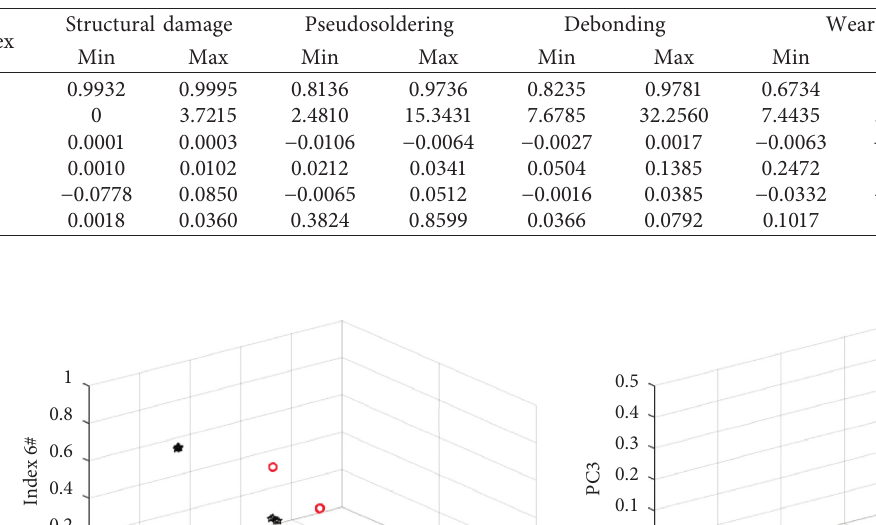
Table 2: The value range of 1–6# indexes under different damage conditions.